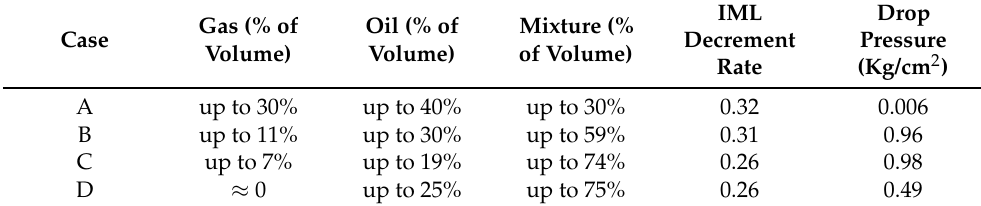
Table 4. Decision criteria for physical